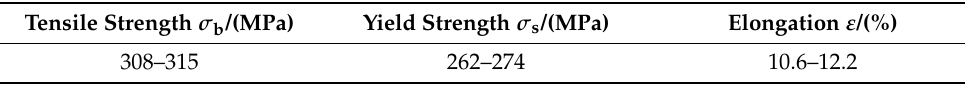
Table 2. Mechanical properties of 6082-T6 aluminum alloy, data from [29]. Tensile Strength σ b